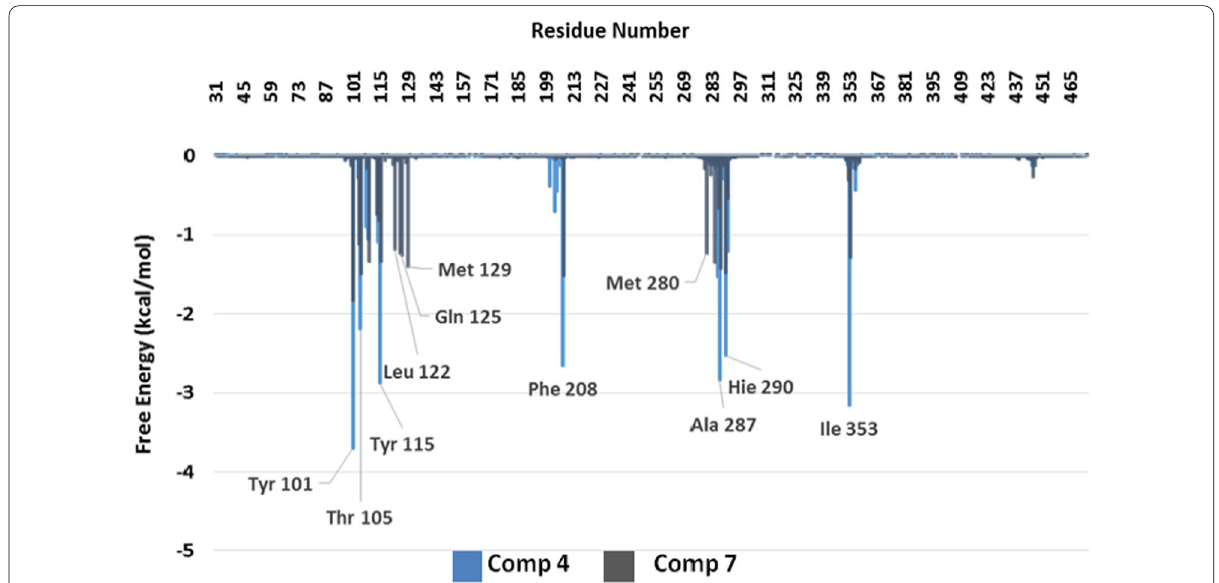
Fig. 7 Interactions obtained for compounds 4 (light blue) and 7 (black) with the active site of the